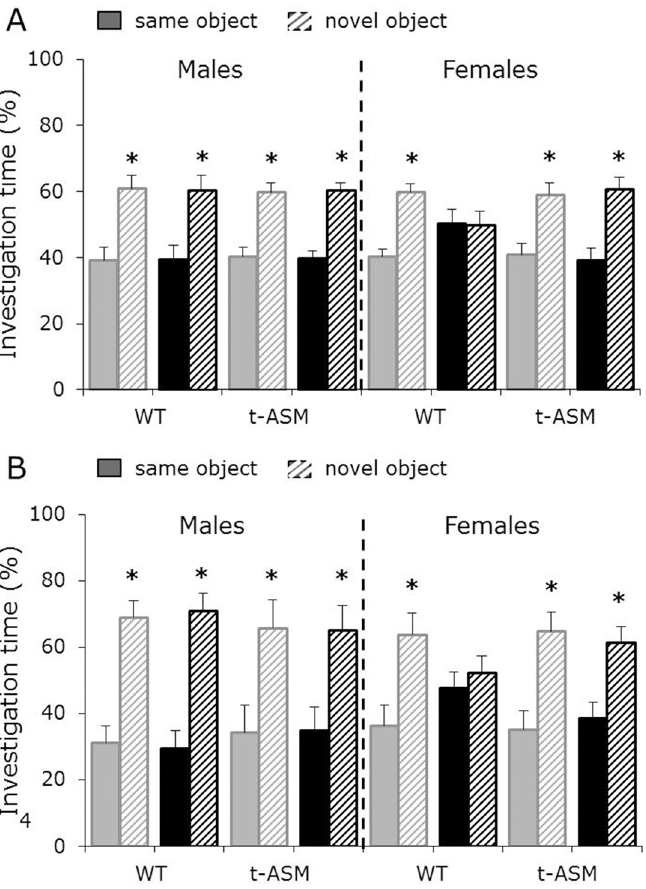
Fig 2. ASM overexpression protected females against the detrimental effects of amitriptyline on non- social memory performance. Percentage investigation of the same and the novel object during the second 5 min of the novel object recognition test (A; n = 10 – 13 per group) and during the discrimination period of the object discrimination test (B; n = 6 per group). Mice were treated with amitriptyline (black bars) or water (grey bars) for 4 weeks before and during behavioral testing. Object recognition (A) and object memory (B), as indicators of intact non-social memory, are reflected by higher investigation time directed towards the novel versus the same object. Shown are means + SEM. * p < 0.05 versus same